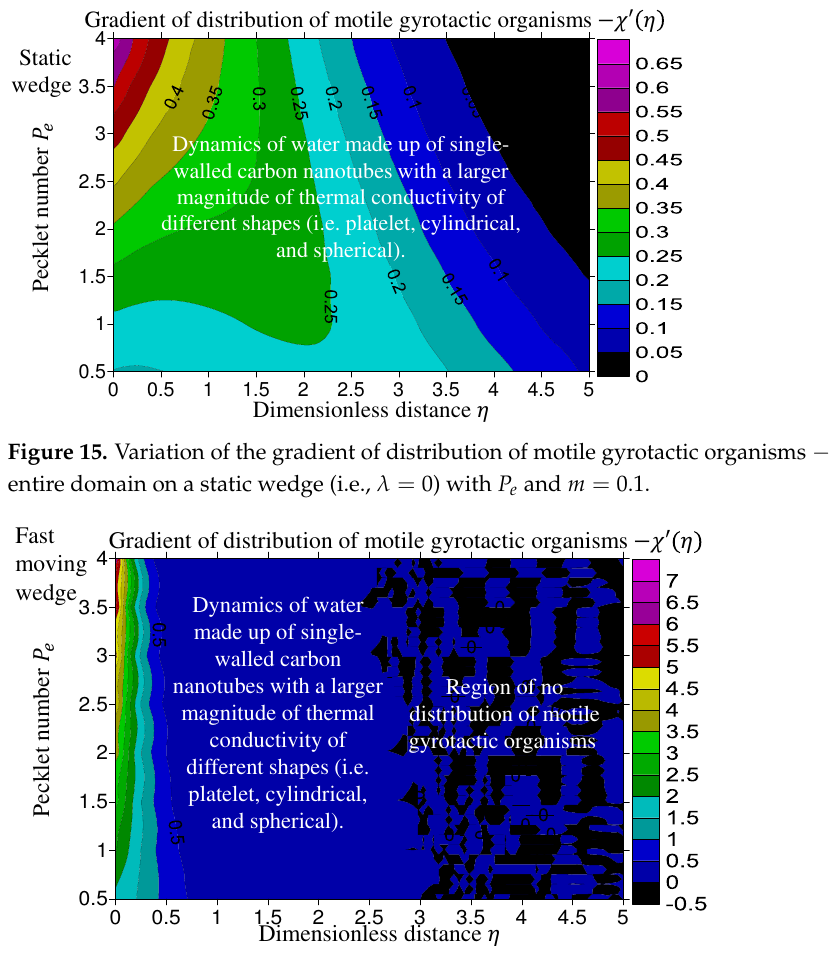
Figure 16. Variation of the gradient of distribution of motile gyrotactic organisms − χ (cid:48) ( η ) within the entire domain on a fast-moving wedge (i.e., λ = 5) with P e and m =